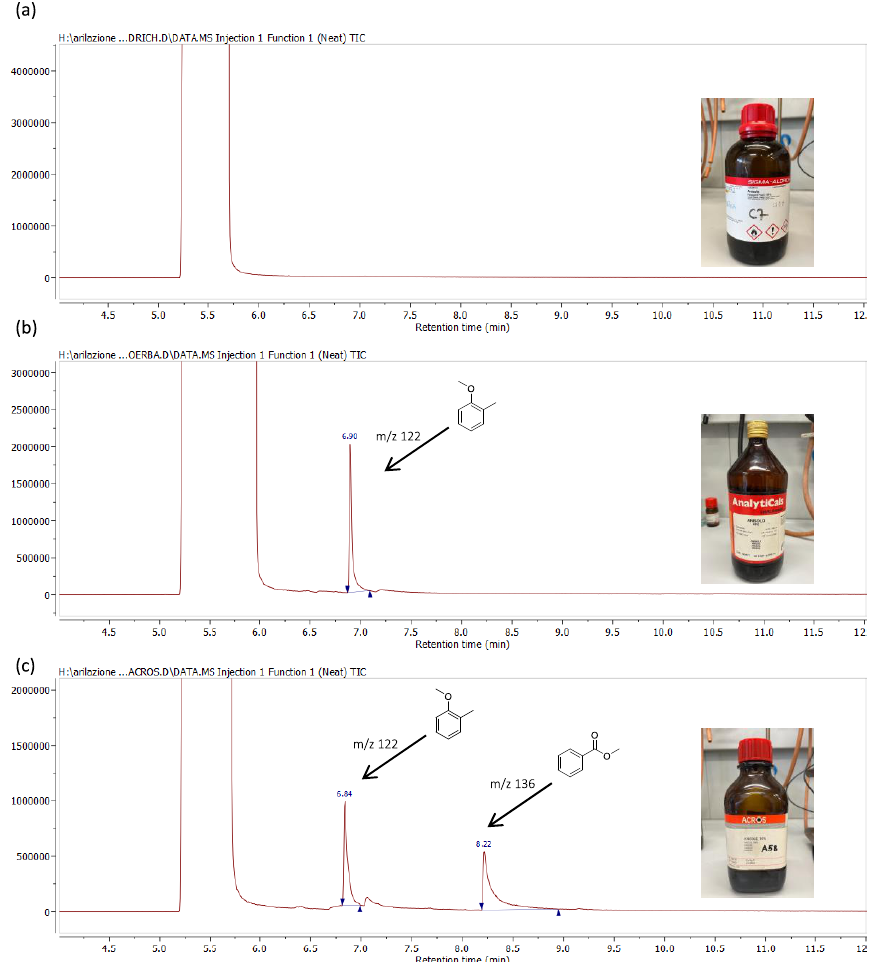
Molecules 2022 , 27 , x FOR PEER REVIEW 7 of 17 Figure 3. GLC-EIMS of anisole from Acros ( a ), Carlo Erba ( b ), and Sigma-Aldrich ( c ).